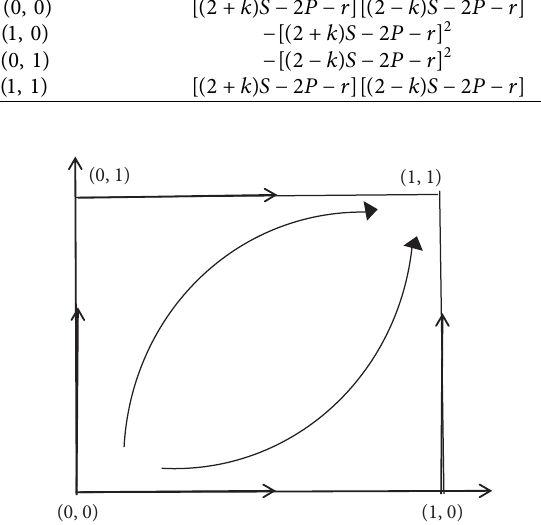
Table 4: Stability of stable points when P < (( 2 − k ) S − r ) /2. Stable point det J tr J